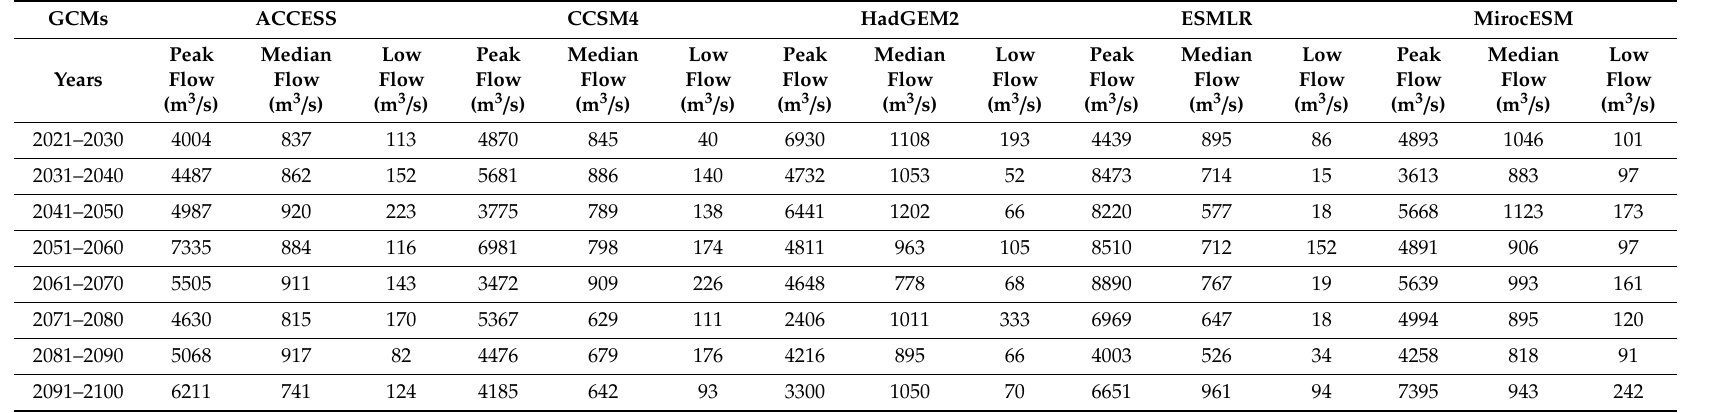
Table A2. Peak, median and low flows (2021–2100) under